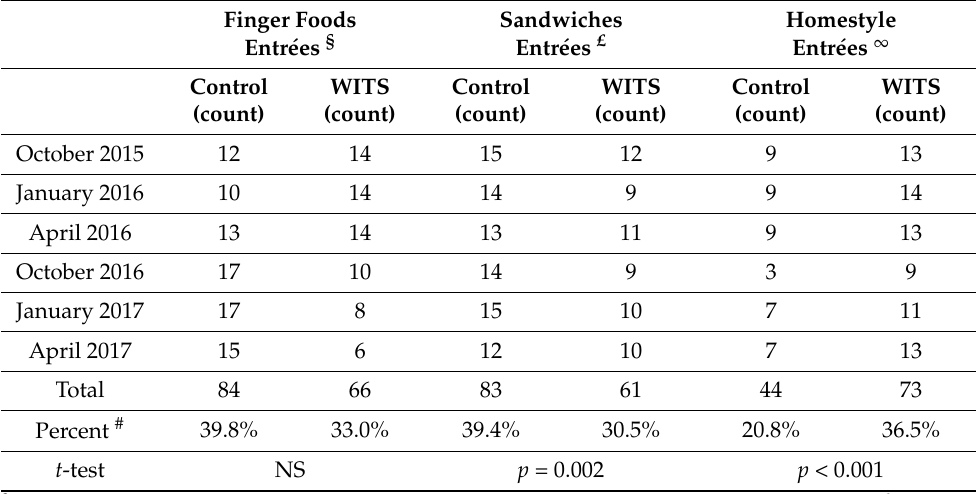
Table 3. Entr é e types offered on regular menu in Control schools and Alternative menus in Wellness in the Schools (WITS) intervention